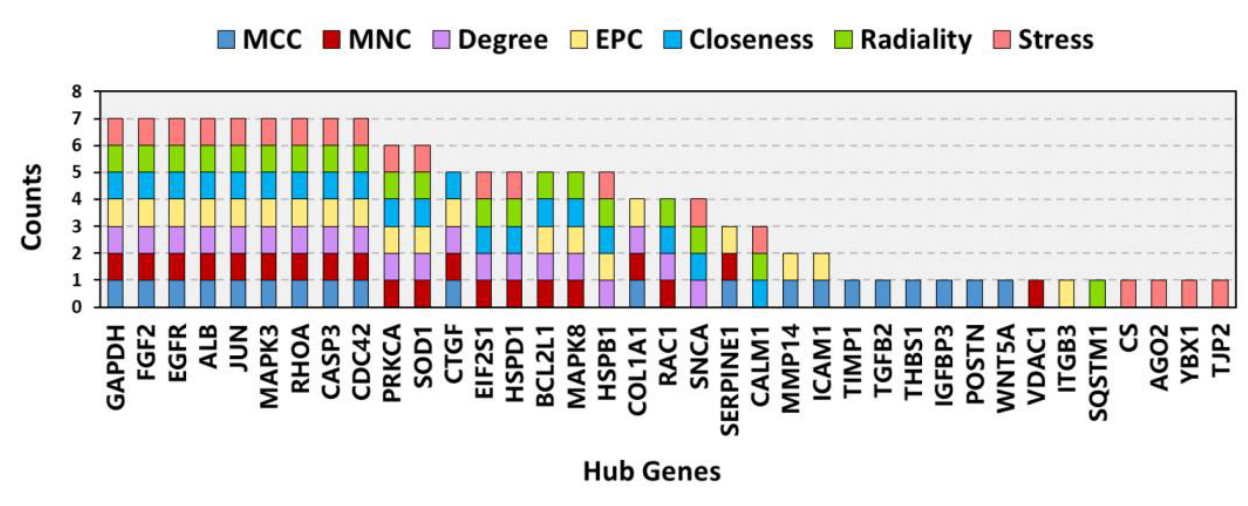
Figure 6. Stacked bar plots of the top 20 hub genes according to seven common algorithms conducted with the plugin cytoHubba.